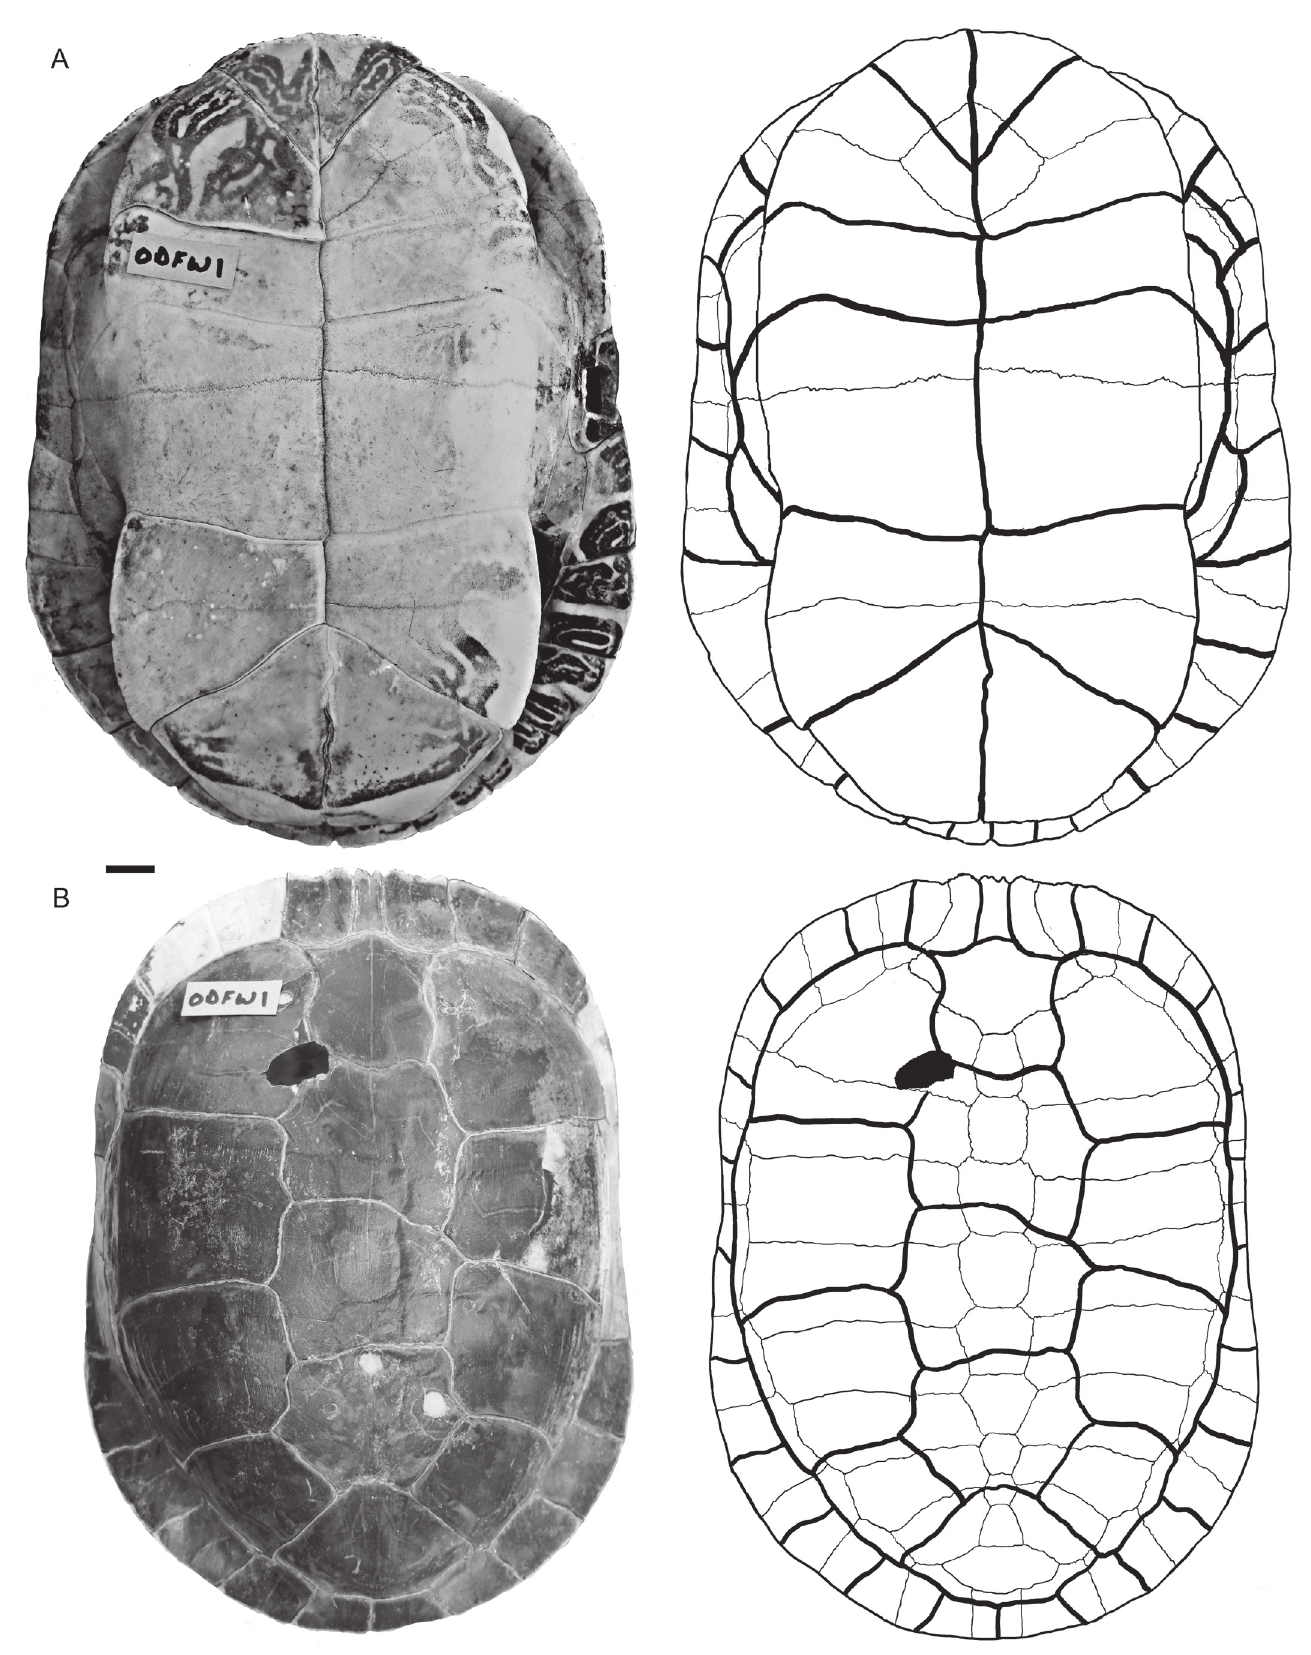
Figure 7. Chrysemys picta bellii, ODFW 1. A, plastron and B, carapace. The black region on the first left costal is an arrow hole. Scale bar = 1